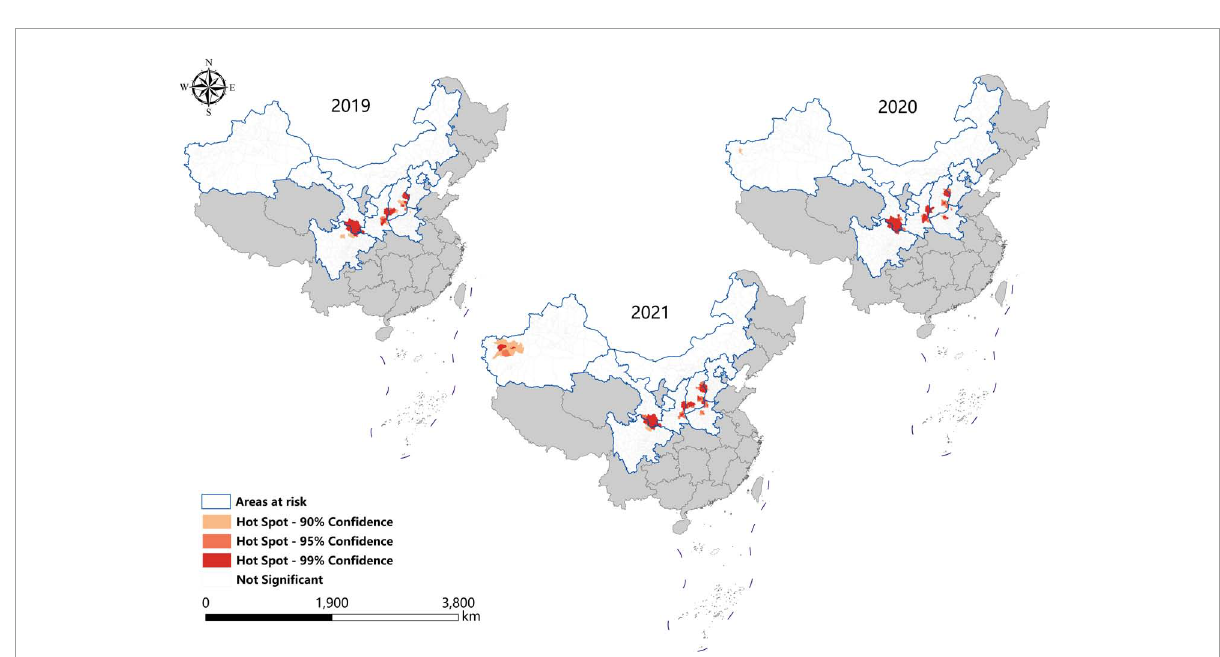
FIGURE5 Hotspot analysis of visceral leishmaniasis incidence in mainland China from 2019 to